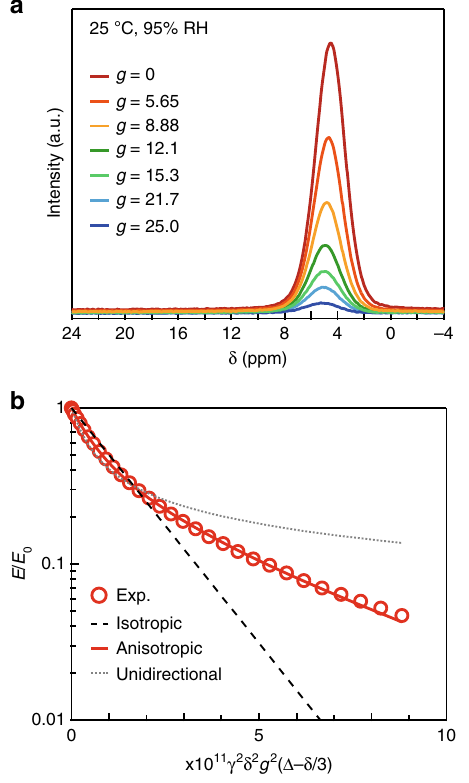
Fig. 4 Intensity decay of the echo of the crystallization water of 1. a Echo decay with selected g values at 25 °C, 95% RH. b Fit to the attenuation of the normalized signal intensity ( E / E 0 ) as a function of g 2 based on the two- component anisotropic diffusion model (see text). Here, the gradient pulse duration ( δ ) is 1 ms, and the diffusion time ( Δ ) is 20 ms. γ is the gyromagnetic ratio of 1 H. Grey dotted line, red solid line and black dashed line are the best fi ts to the experimental data (red circle) using isotropic, anisotropic and unidirectional diffusion model, respectively.